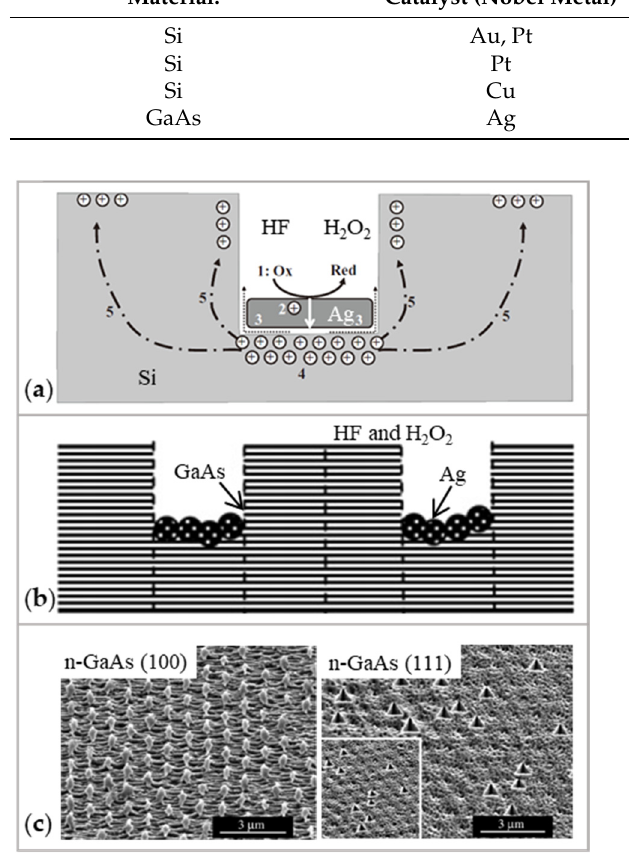
Table 4. The processed material with different catalysts, etchants, and oxidants using MACE. Material.